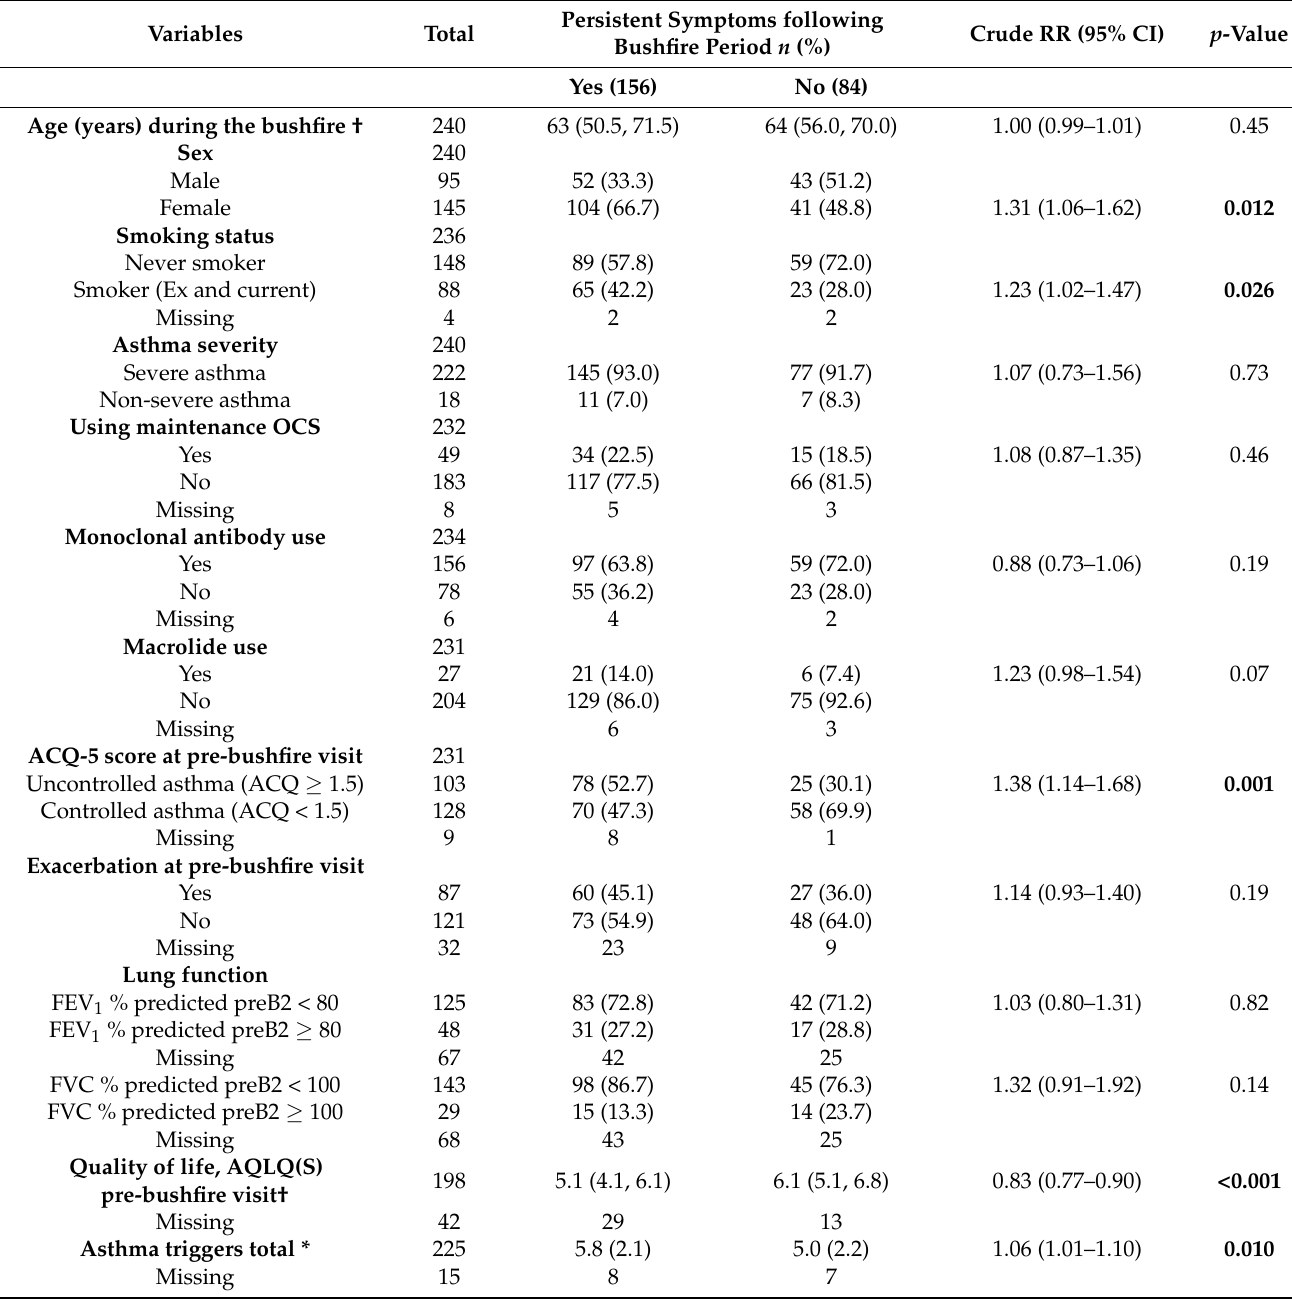
Table 4. Demographic and clinical characteristics in asthma participants with and without persistent